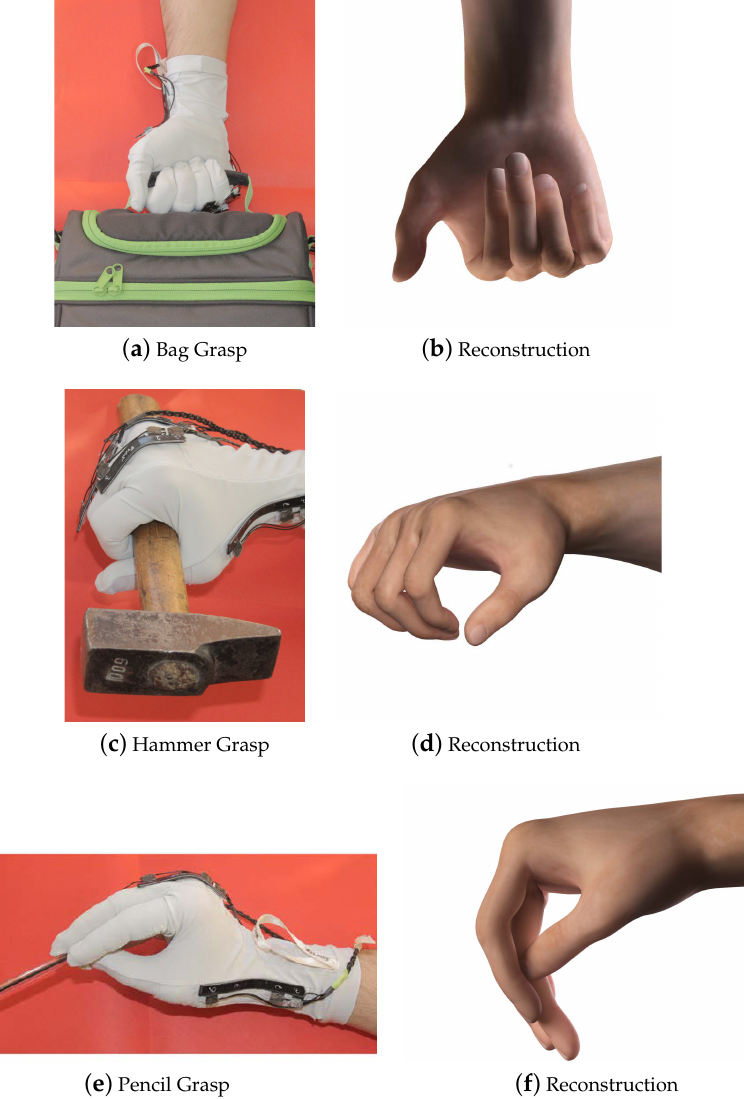
Figure 8. Comparison between real and reconstructed grasps (obtained from the five measurements extended to the 19-DOF pose and rendered in 3D Studio